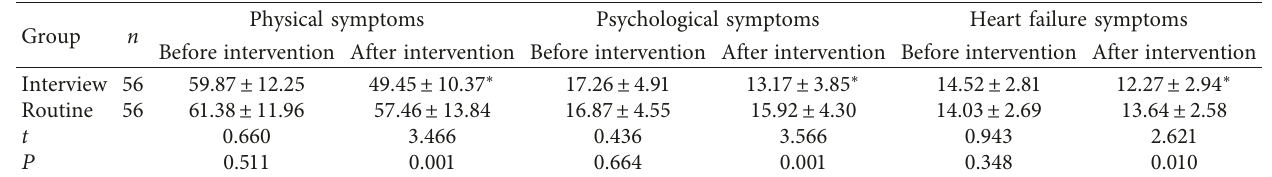
Table 1: Comparison of the psychological status between the two groups before and after intervention ( x ± s , points). Depression Anxiety Group N Before intervention After intervention Before intervention After intervention Before intervention After intervention Interview 56 Routine — 0.662 < 0.001 0.001 Note . Compared with before intervention, ∗ P < 0 . 05. Table 2: Comparison of symptoms before and after intervention in the two groups ( x ± s , points). Physical symptoms Group n Before intervention After intervention Before intervention After intervention Before intervention After intervention Interview 56 Routine Note .Compared with before intervention, ∗ P < 0 .